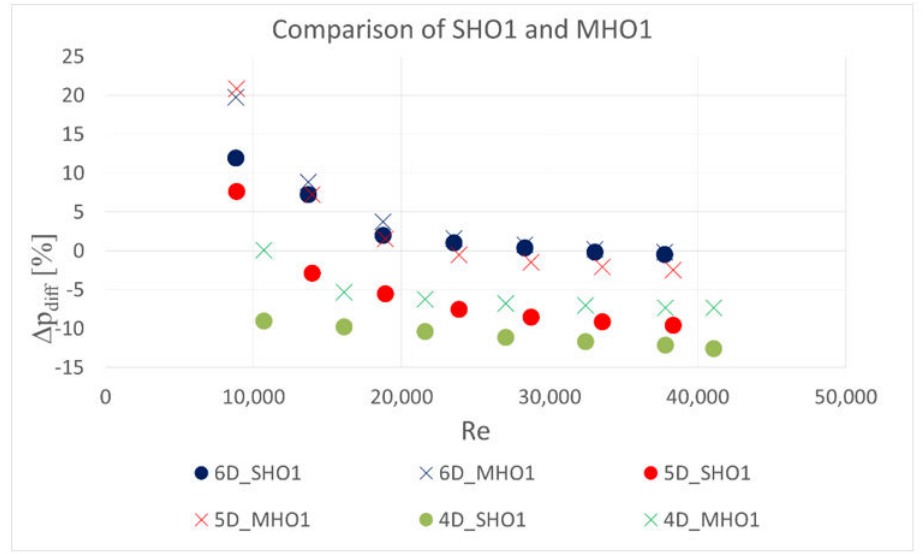
Figure 15. Comparison of multi-hole orifice and single-hole orifice with contraction coe ffi cient of